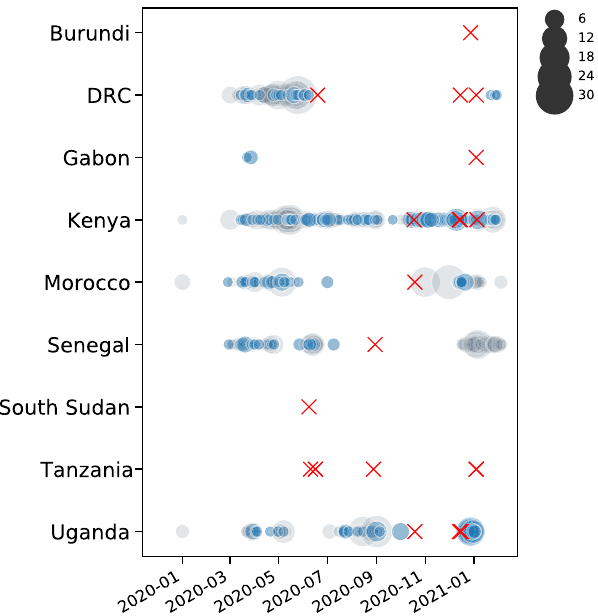
Fig. 3 Availability of whole genome sequences for African countries from which travelers entered Rwanda. Gray circles denote the number of sequences available in GISAID for each country on a given date. Blue circles correspond to the number of sequences included in our analyses. Red crosses mark the collection dates of Rwandan sequences with travel history from the respective countries. Although few to no sequences are available from Burundi, Gabon, South Sudan, and Tanzania, these travel history data point to SARS-CoV-2 lineages circulating in these countries, to the extent that returning travelers from these countries import those lineages into Rwanda.